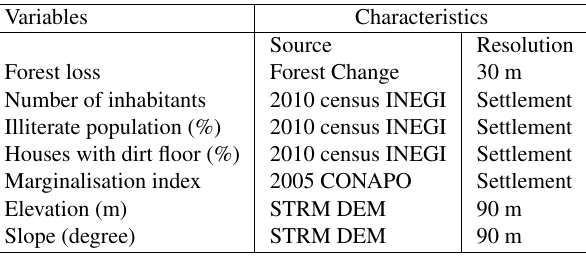
Table 1: Input variables characteristics